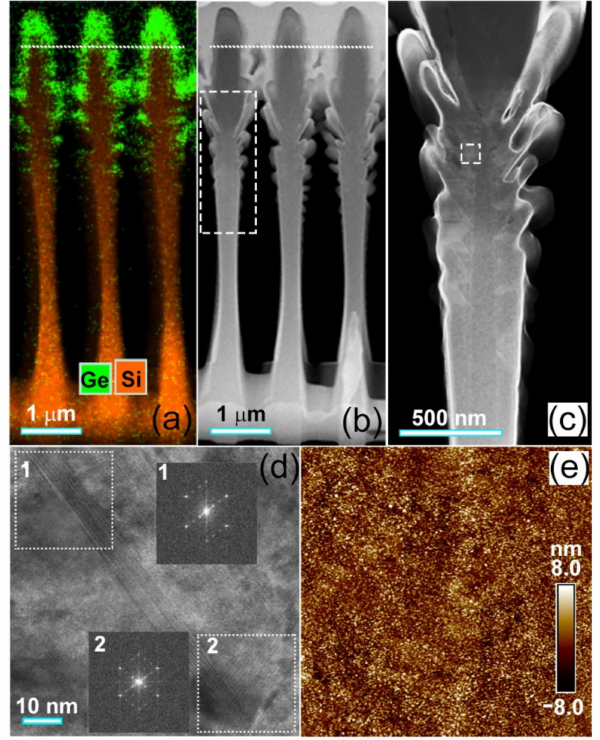
Figure 3. STEM and AFM images. ( a ) STEM-EDS mapping of Ge and Si in sidewalls, ( b ) STEM- HAADF image across the nearest neighboring micro-holes, ( c ) enlarged STEM-HAADF image of dash-boxed region in ( b ), ( d ) high resolution STEM image of dash-boxed region in ( c ), ( e ) AFM image (5 × 5 µ m 2 ) of the reference sample after growth on a flat substrate. The dotted line in ( a , b ) denotes the growth onset of Ge x Si 1 − x alloys. The insets (1, 2) in ( d ) are the FT patterns of STEM images in the dot-boxes (1,